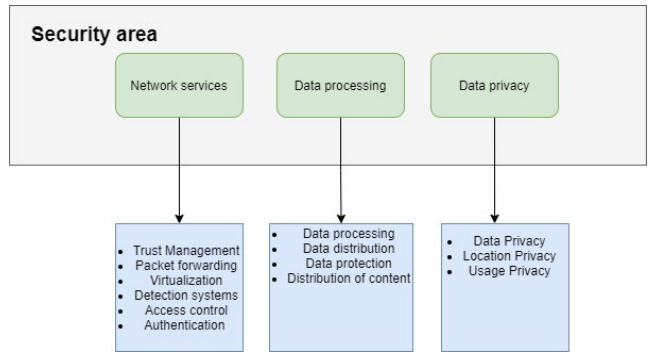
Figure 4. Security areas in fog